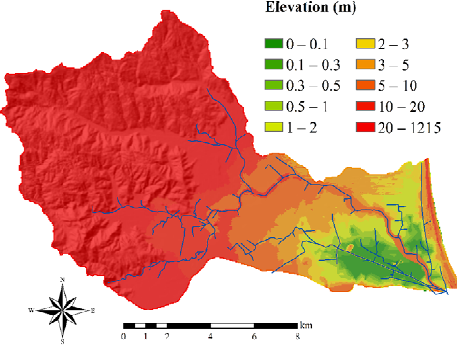
Figure 4. High-resolution elevation map of the Yilan River basin.